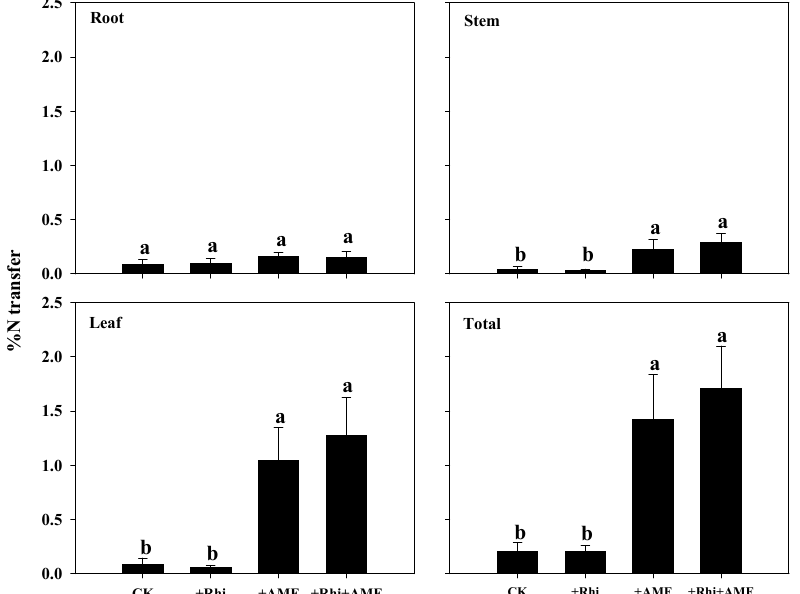
Figure 4. Percentage of nitrogen transfer in various parts of citrus affected by rhizobial and mycorrhizal inoculation. Data are means ± SE ( n = 4). Different letters above columns indicate significant differences ( p < 0.05) between treatments. Abbreviations: CK, no rhizobium and no arbuscular mycorrhizal inoculation; +Rhi, inoculated with rhizobium; +AMF, inoculated with mycorrhizal